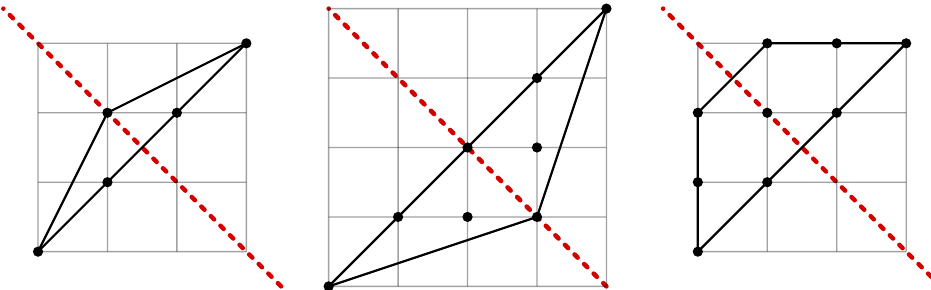
Figure 20. Examples of trapezoids, which admit anomaly-free fixed line